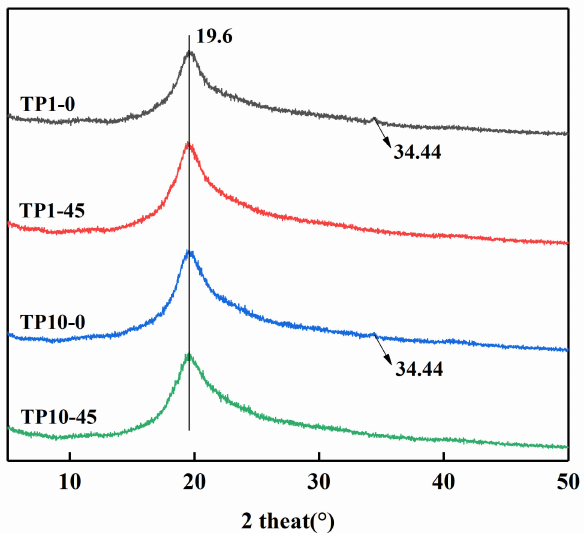
Figure 4. X-ray diffraction patterns of different mass ratios of PVA-HC/TP under different ultrasonic